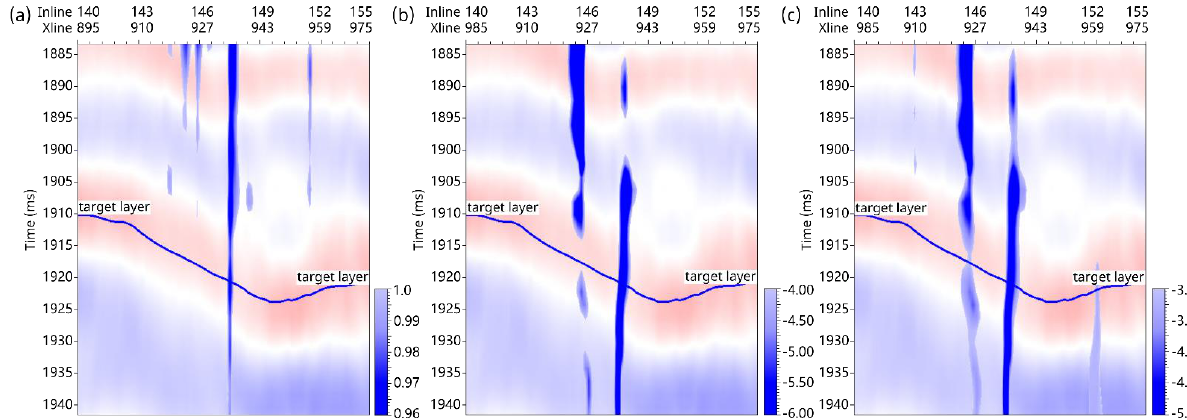
Figure 7. Different attributes crossed line 3. ( a ) Amplitude vs. coherence, ( b ) amplitude vs. PC , ( c ) amplitude vs. PC (new method).